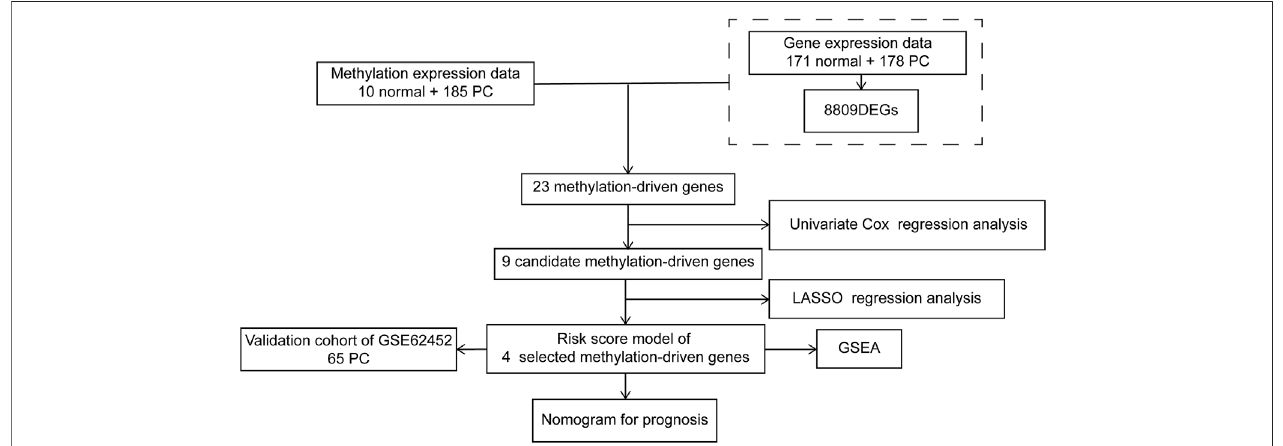
FIGURE 1 | The fl ow diagram of the research